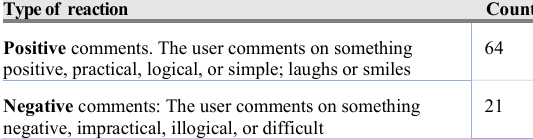
Table 3. User reactions during the experiment Type of reaction